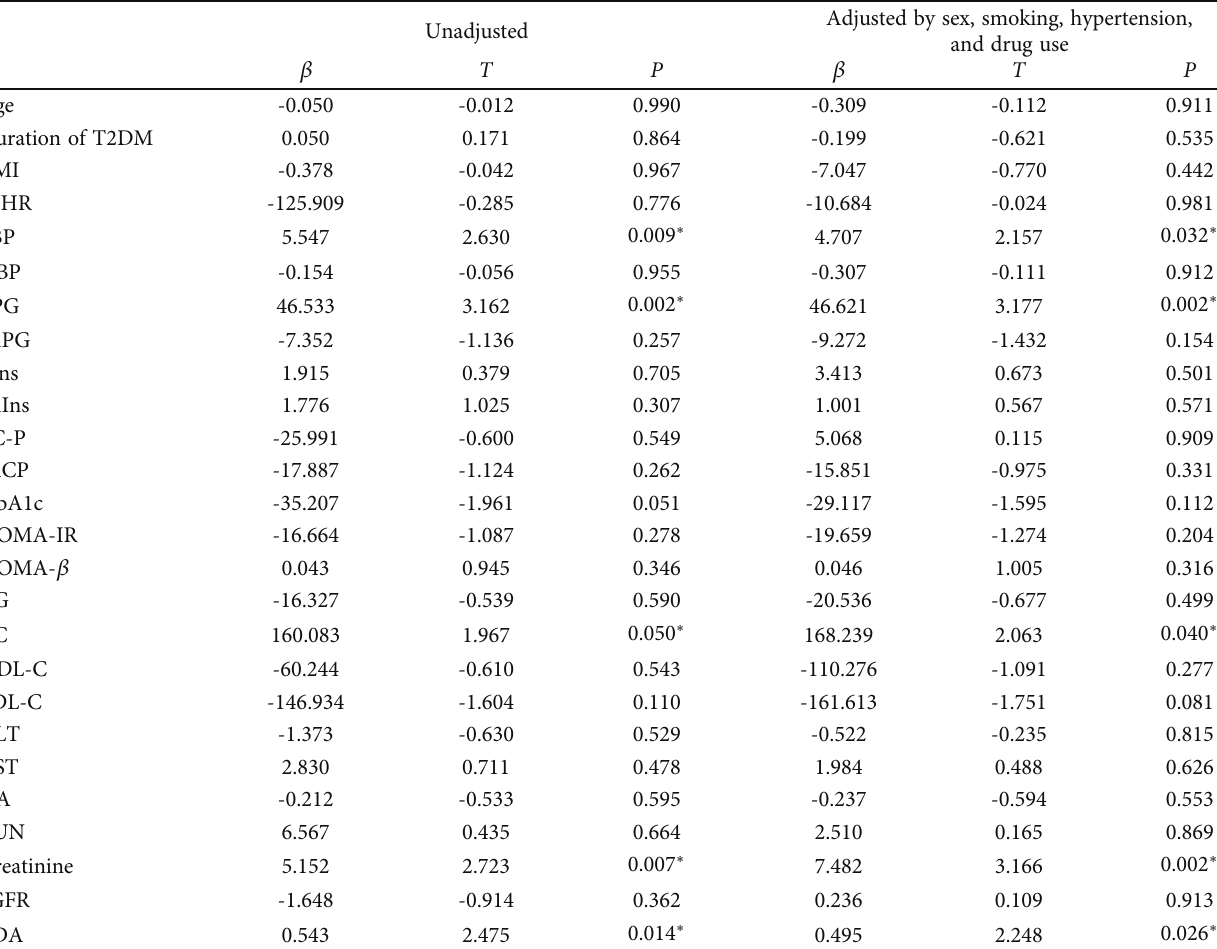
Table 5: Results of multiple linear regression analysis for UACR in T2DM patients.